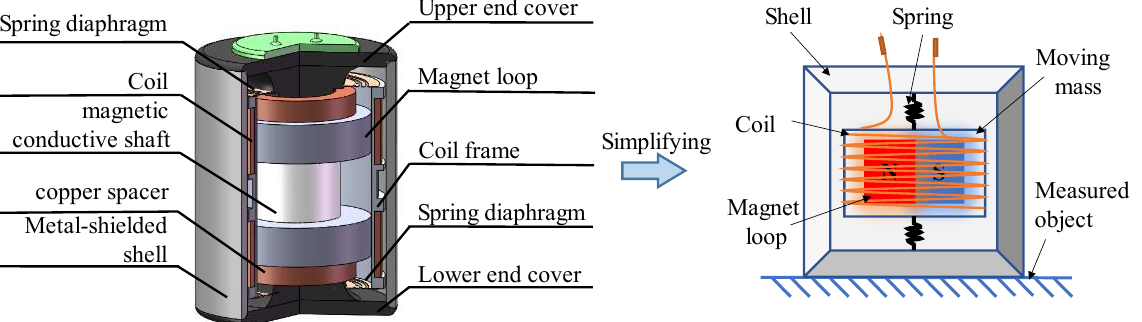
Figure 8. Dual-magnet velocity sensor and its simplified model.